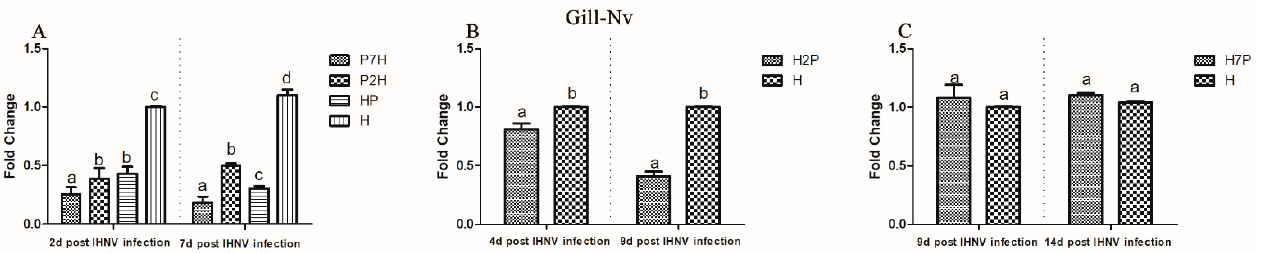
Figure 4. IHNV Nv genes in the gill determined by qRT-PCR. Rainbow trout challenged with IHNV (group H) were used as controls. Different letters on the bar charts indicate statistically significant differences ( p < 0.05). ( A ) The levels of IHNV Nv gene in groups P7H, P2H, and HP. ( B ) The levels of IHNV Nv gene in group H2P. ( C ) The levels of IHNV Nv gene in group H7P.